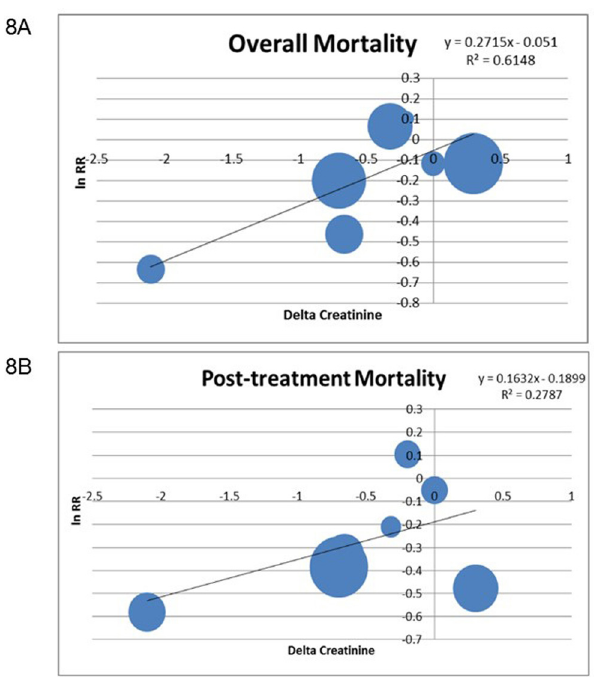
Fig 8. Correlation Between Change in Serum Creatinine During Treatment and Relative Risk of Overall Mortality. Bubbles graphs depict the correlation between changes in creatinine while on treatment with overall (7a) and post-treatment (7b) mortality. The intercept represents the fall in relative risk for mortality per each fall in serum creatinine of 1 mg/dL.